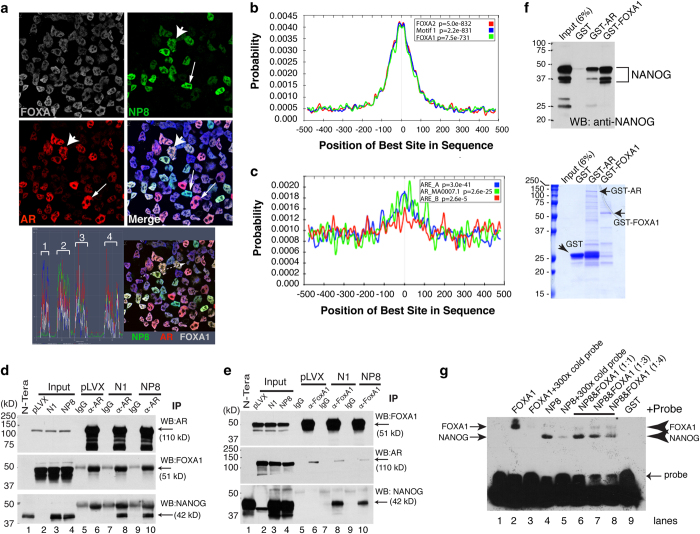
NANOG co-localizes and interacts with AR and FOXA1. (a) Multispectral confocal immunofluorescence analysis of NANOG (rabbit mAb, green), AR (mouse mAb, red) and FOXA1 (goat pAb, gray) in LNCaP-NP8 cells (the lower right panel being the four-color merge). Cells were counterstained by 4,6-diamidino-2-phenylindole (blue). Arrows indicate NP8- or AR-expressing cells, whereas the arrowhead marks a NP8/AR co-expressing cell. Shown below are semi-quantitative spectral peaks of four cells (left) circumscribed on the right image in white dashed line. (b) CentriMo analysis of the positional distribution of FOXA family motifs (motif 1, FOXA1 and FOXA2) ±500 bp of the pinnacle. (c) CentriMo analysis of the positional distribution of AR family motifs (AR full motif MA0007.1 and AR half motifs ARE_A and ARE_B) ±500 bp of the pinnacle. (d, e) NANOG interacts with both AR and FOXA1 in LNCaP cells. Whole-cell lysate from the indicated cell types (that is, LNCaP-pLVX control and LNCaP-overexpressing NANOG1 or NP8) were used in immunoprecipitation (IP) with either anti-AR rabbit pAb followed by western blot (WB) with anti-AR mouse mAb, anti-FOXA1 goat pAb and anti-NANOG mouse mAb (d) or IP with anti-FOXA1 goat pAb followed by WB with anti-FOXA1 rabbit pAb, anti-AR mouse mAb and anti-NANOG rabbit mAb (e). N-tera EC cell lysate was used as a positive control for NANOG (42 kDa; lane 1). (f) Recombinant NP8 interacts with both AR and FOXA1 in cell-free systems. GST pull-down assays were performed as described in Supplementary Methods and bound proteins were separated by SDS–polyacrylamide gel electrophoresis (SDS/PAGE) and used in WB with an anti-NANOG antibody (Cell Signaling). Shown below is a Coomassie blue-stained gel image. The rhNANOG proteins were detected as 48, 42 and 35 kDa species [14]. (g) NP8 binds the FOXA1 consensus DNA motif. EMSA was performed using biotinylated FOXA1 motif in the UBE2C gene promoter as the probe (lane 1). Upon incubating the indicated recombinant proteins (lanes 2–8) or GST alone (lane 9) with the probe, interacting proteins were separated by SDS–PAGE and detected using streptavidin horseradish peroxidase. Note that cold unlabeled probes significantly reduced binding of FOXA1 (lane 3) or NP8 (lane 5) to the biotinylated probe. The arrowheads (right) indicate the increasing amounts of FOXA1 and decreasing amounts of NANOG with increasing ratio of FOXA1 over NP8 (lanes 6–8).